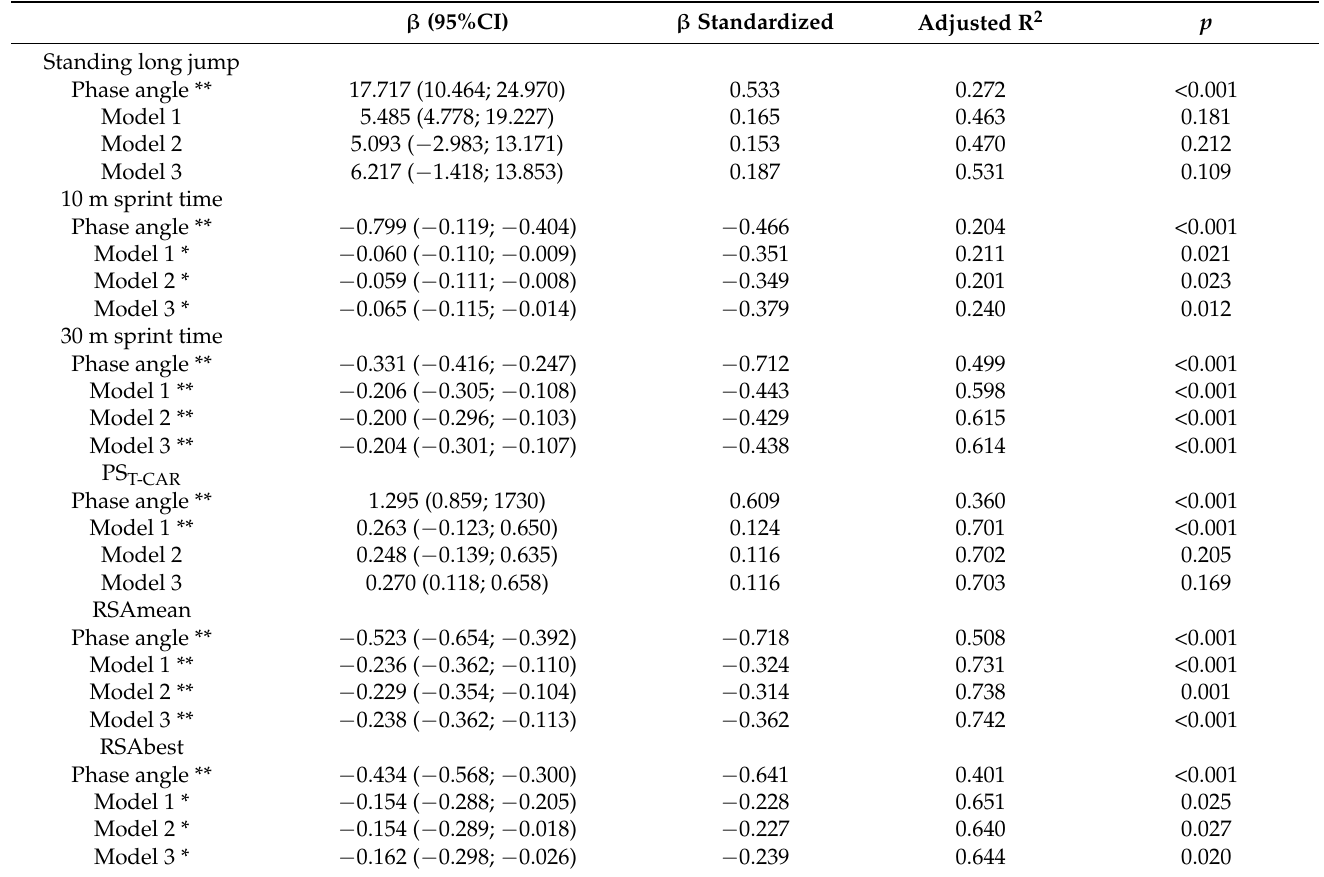
Value “ p ” in the table corresponds to the phase angle in the raw and adjusted model. * Significant model ( p < 0.05); ** significant model ( p ≤ 0.001); Model 1: phase angle adjusted by the age; Model 2: phase angle adjusted by the age and lean soft tissue mass; Model 3: phase angle adjusted by the age, lean soft tissue mass, and absolute body